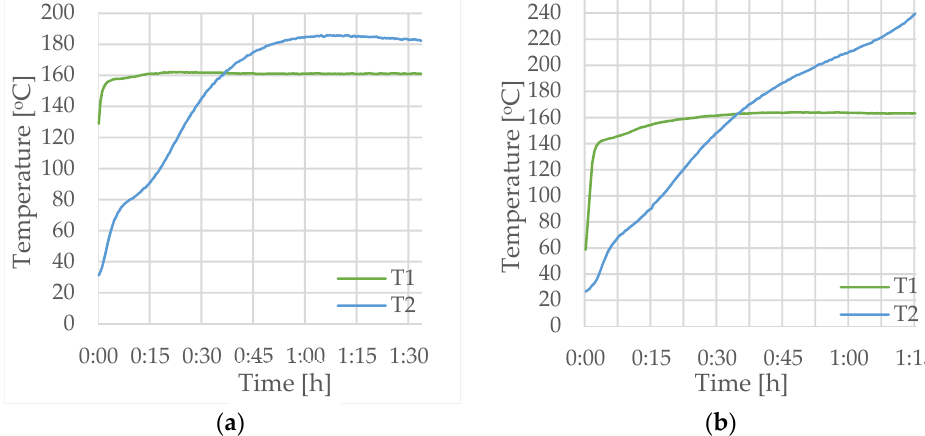
Figure 4. The temperature of sludge dust in a 21.21 cm 3 basket: ( a ) at a furnace temperature of 160 °C with no evidence of dust ignition, ( b ) at a furnace temperature of 162 °C with a dust ignition.